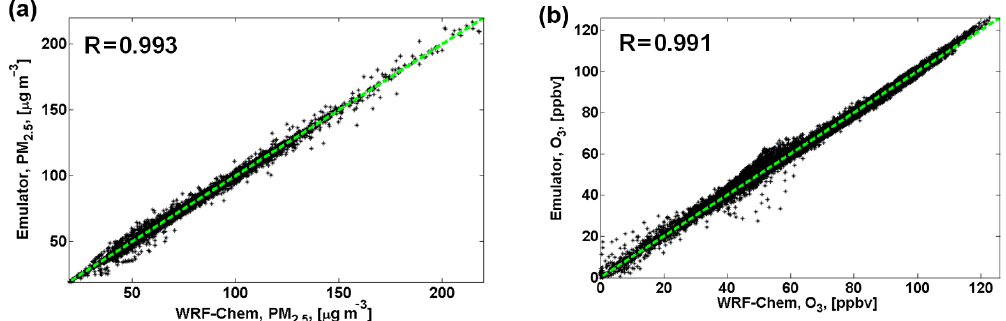
Figure 3. Validation of Gaussian process emulator with WRF-Chem model. (a) PM 2 . 5 ; (b) O 3 . The green dashed line indicates the 1 : 1 line.